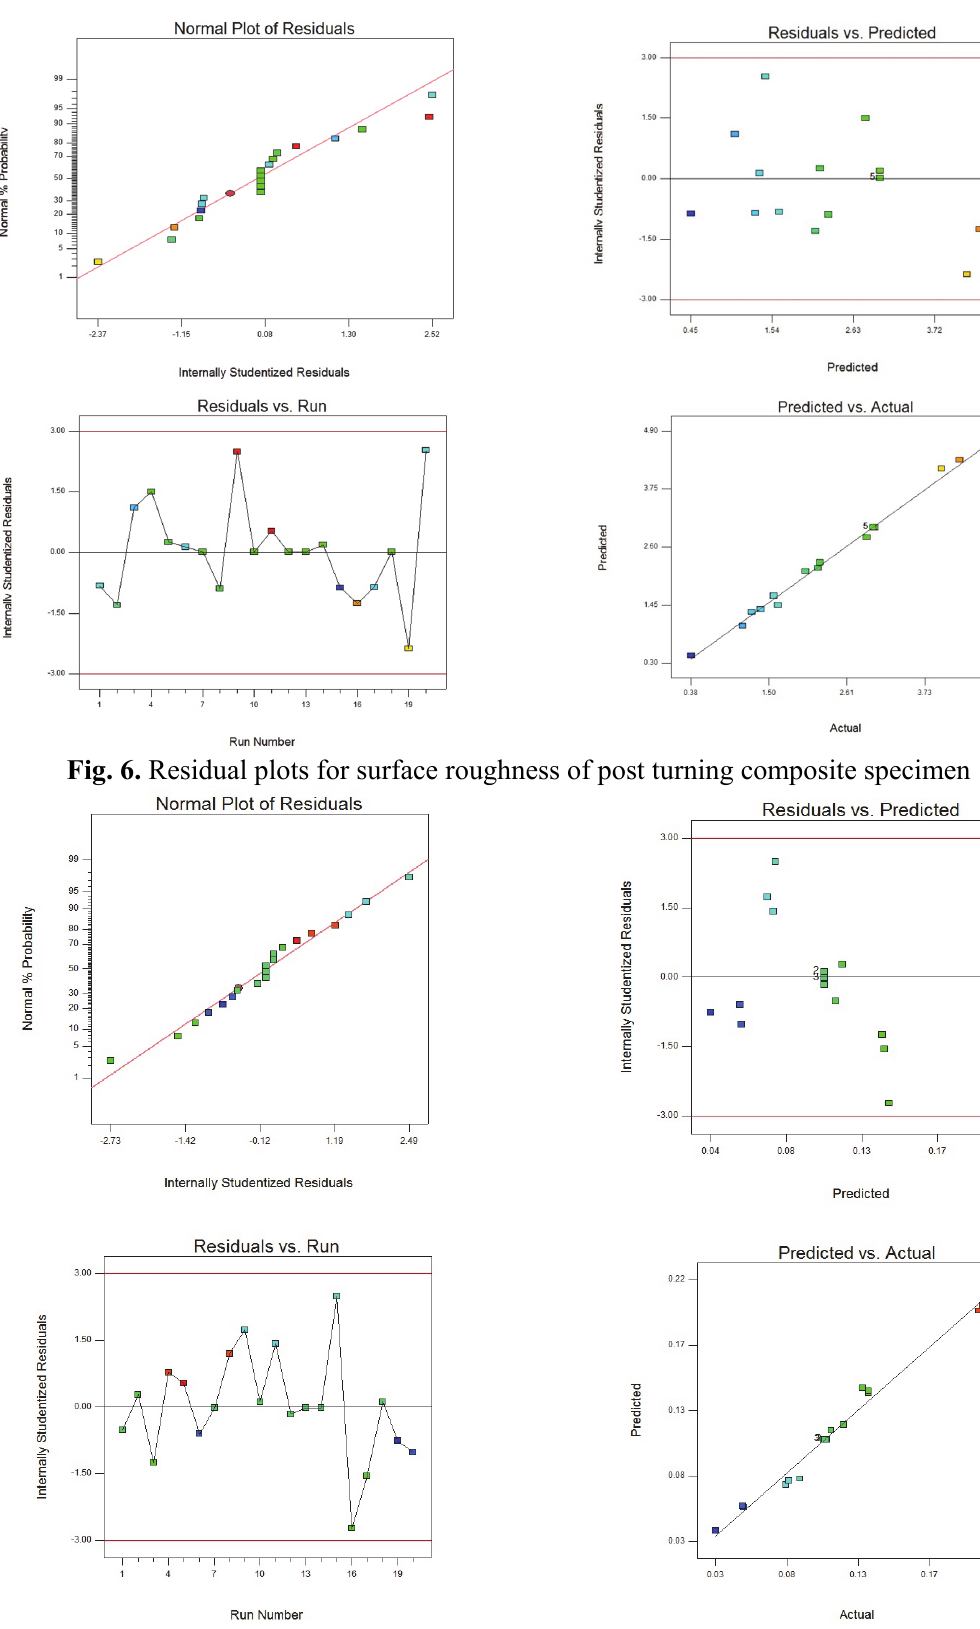
Fig. 7. Residual plots for tool wear of post turning Al-Si alloy